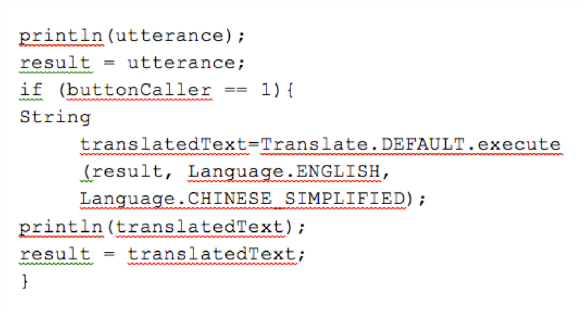
Figure 8 | code snippet from Toast processing sketch.